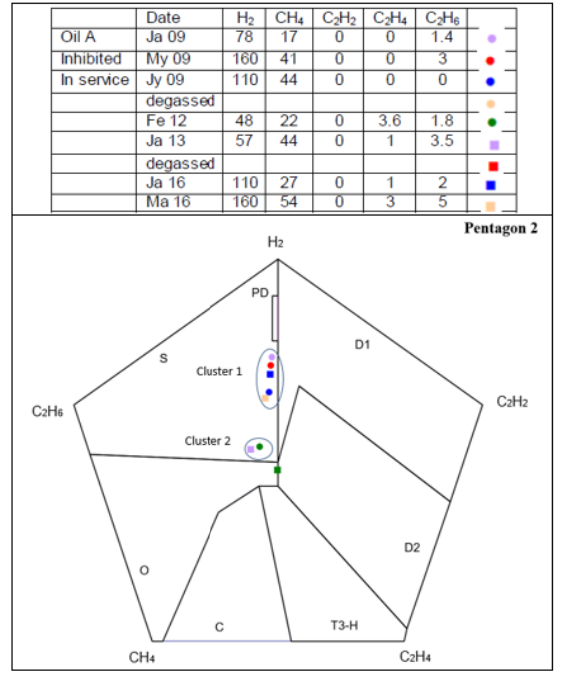
Figure 2. SG of inhibited mineral oil A in a transformer of the FKH, in Clusters 1 and